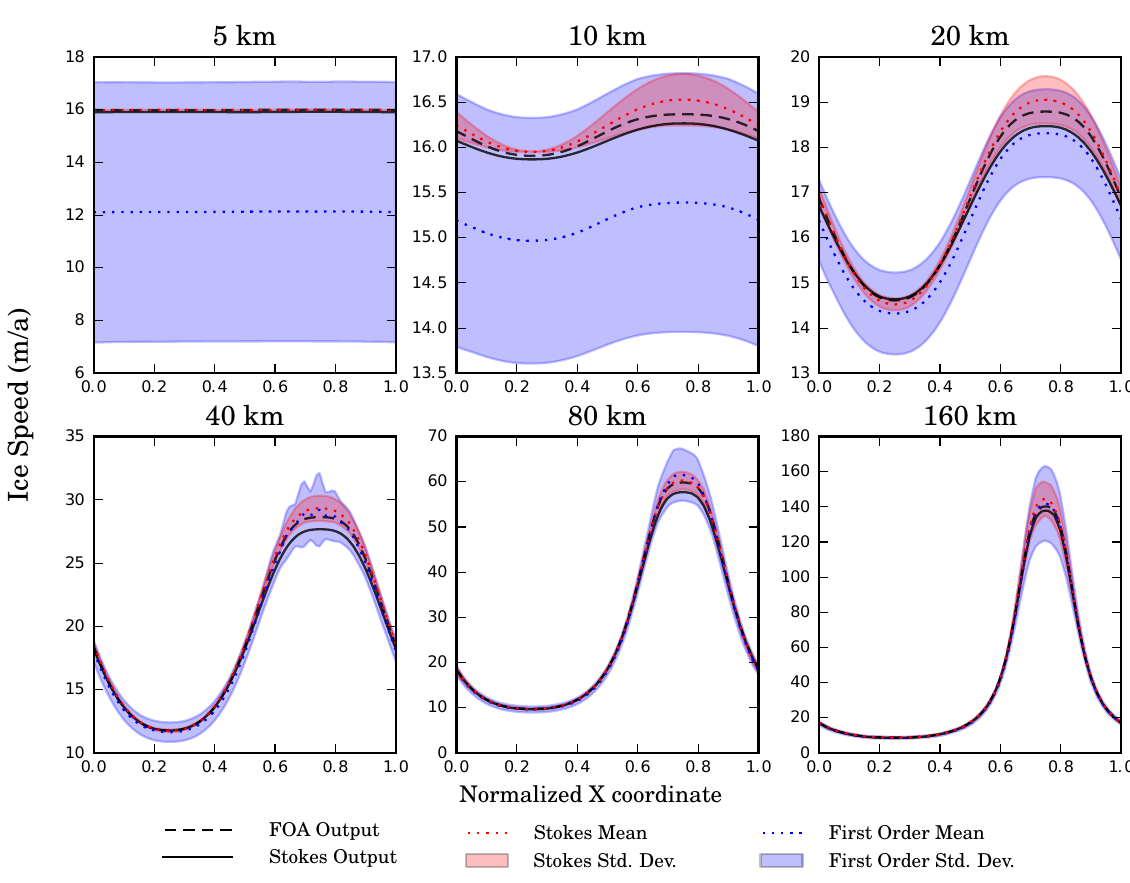
Fig. 6. ISMIP-HOM C performed using first-order and Stokes’